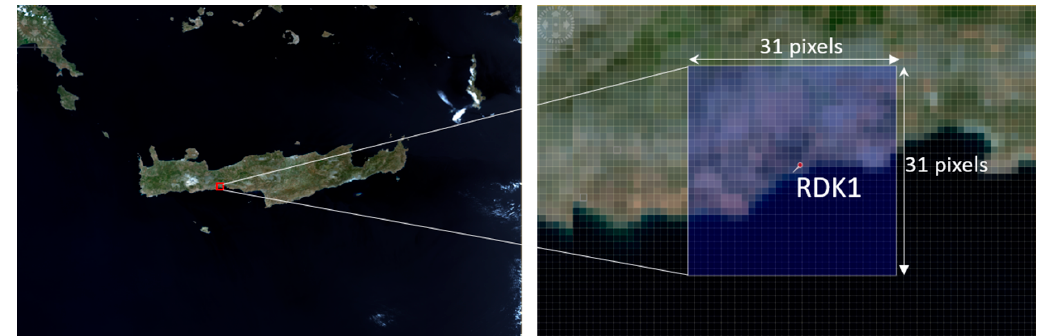
Figure 5. Graphical illustration of the two approaches implemented to derive the OLCI IWV value per image per GNSS station. The image above shows such an example for the Sentinel-3B OLCI image acquired on 21 June 2020 and the RDK1 GNSS station used for validation. In the “single-point” approach, the IWV value of the pixel which contains the GNSS station (RDK1 in image) is used. In the “area-of-influence” approach, the average IWV value of an OLCI window of 30 × 30 pixels is calculated to be compared against the GNSS-derived IWV.